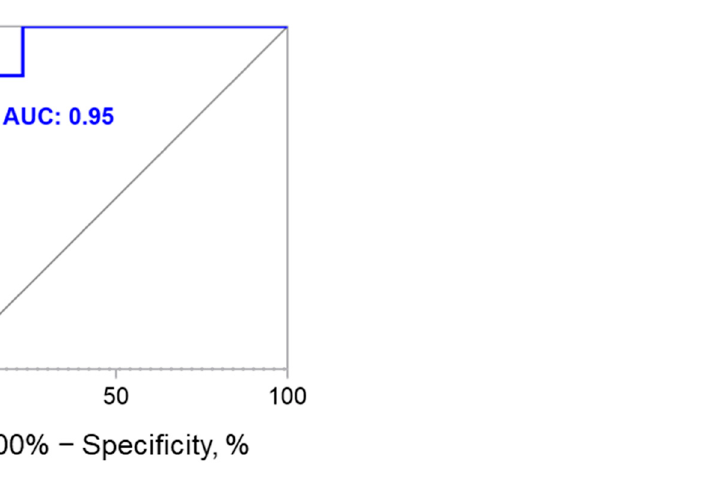
Figure 5. The ROC curve analysis of circulating miR-499a-5p for detecting MYH7 -positive HCM patients. ROC—receiver operating characteristic; AUC—area under the